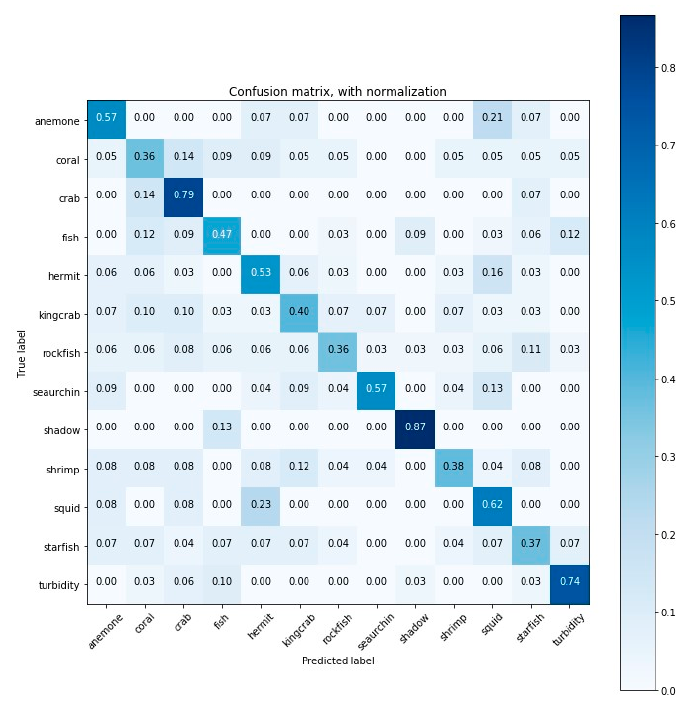
Figure A5. Confusion matrix for the classification results (accuracy) obtained by decision tree (DT) DT-1.